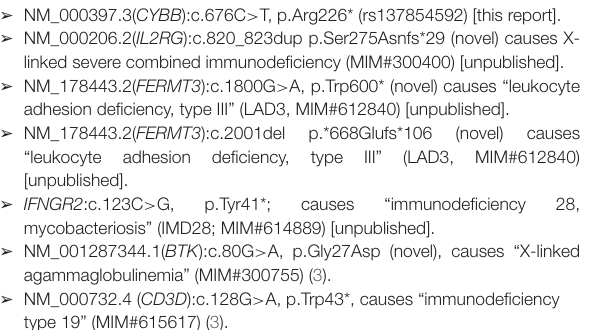
TABLE 2 | Variants of Mendelian susceptibility to mycobacterial disease (MSMD) found in the UAE. (cid:226) NM_000397.3( CYBB ):c.676C > T, p.Arg226* (rs137854592) [this report]. (cid:226) NM_000206.2( IL2RG ):c.820_823dup p.Ser275Asnfs*29 (novel) causes X- linked severe combined immunodeficiency (MIM#300400) [unpublished]. (cid:226) NM_178443.2( FERMT3 ):c.1800G > A, p.Trp600* (novel) causes “leukocyte adhesion deficiency, type III” (LAD3, MIM#612840) [unpublished]. (cid:226) NM_178443.2( FERMT3 ):c.2001del p.*668Glufs*106 (novel) causes “leukocyte adhesion deficiency, type III” (LAD3, MIM#612840)